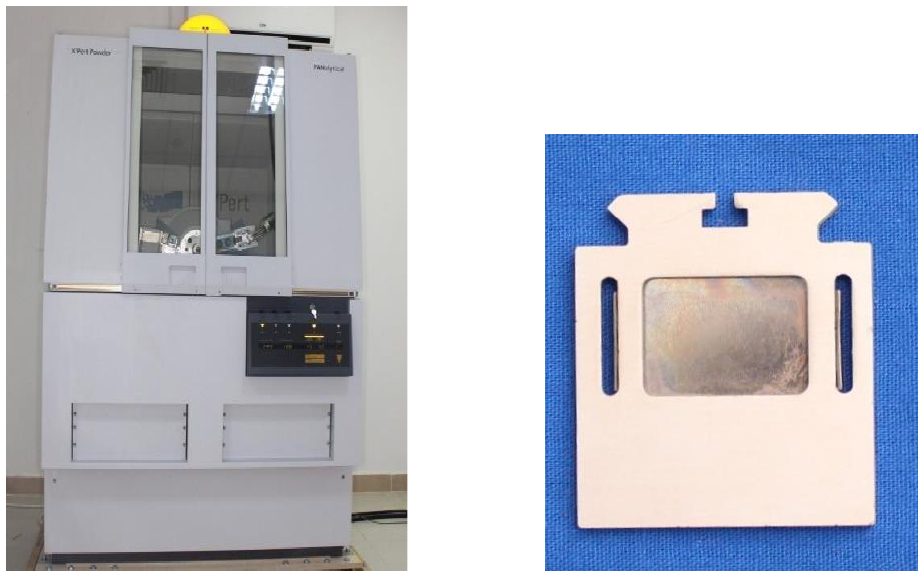
Figure 1 : a) PANalytical X’pert powder